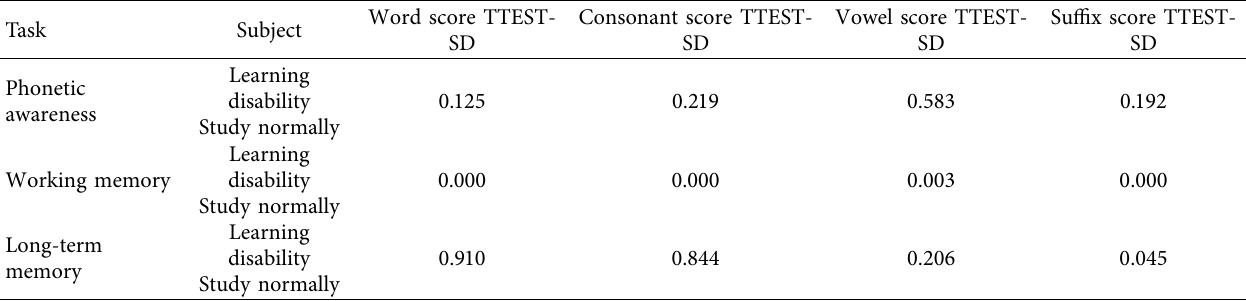
Table 5: t -test analysis of SD on each task of words, consonants, vowels, and suffixes of two types of students.